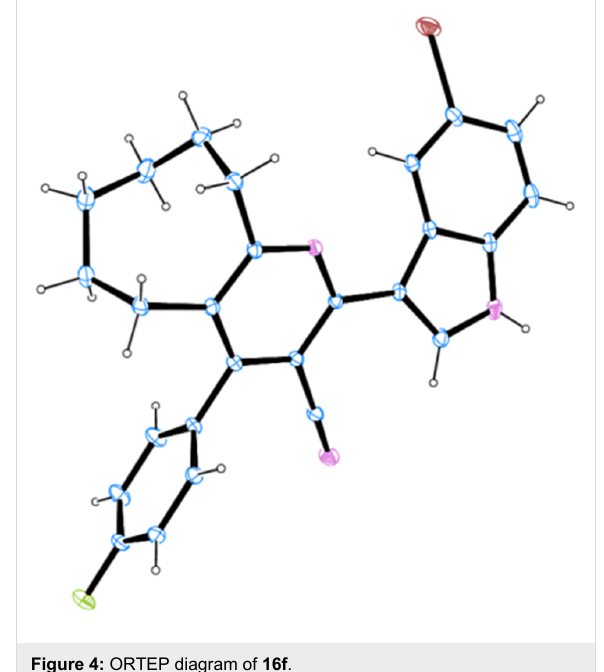
Figure 4: ORTEP diagram of 16f